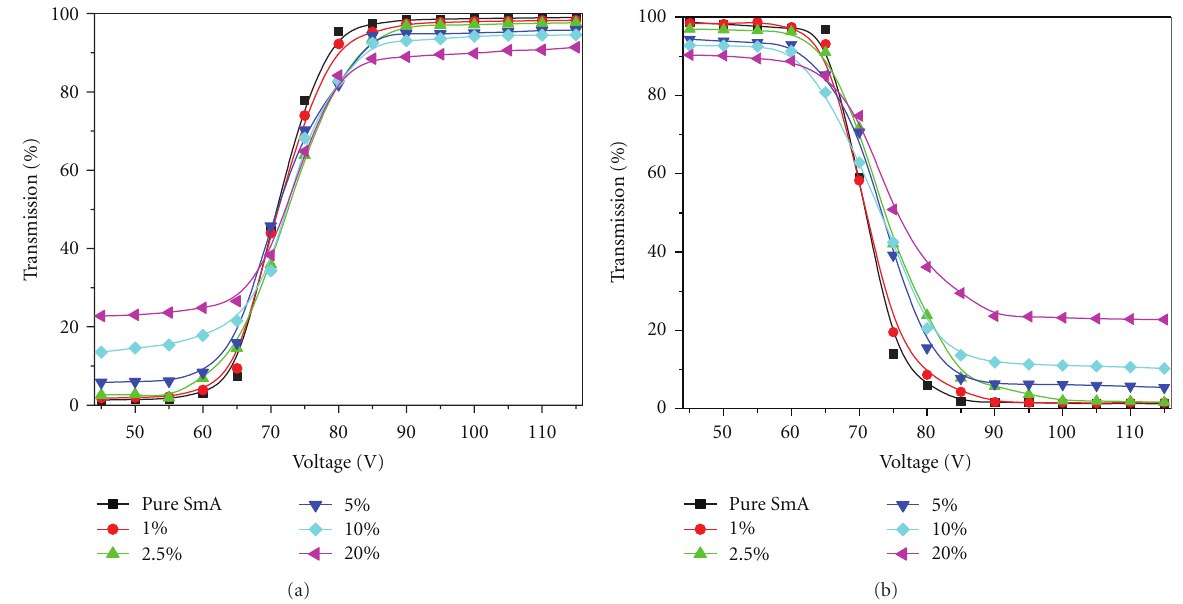
Figure 5: Static-response curves for pure SmA, cell with 1%, 2.5%, 5%, 10%, 20% monomer for FC-HT and EHDI transitions at (a) 5kHz and (b) 50Hz, respectively.